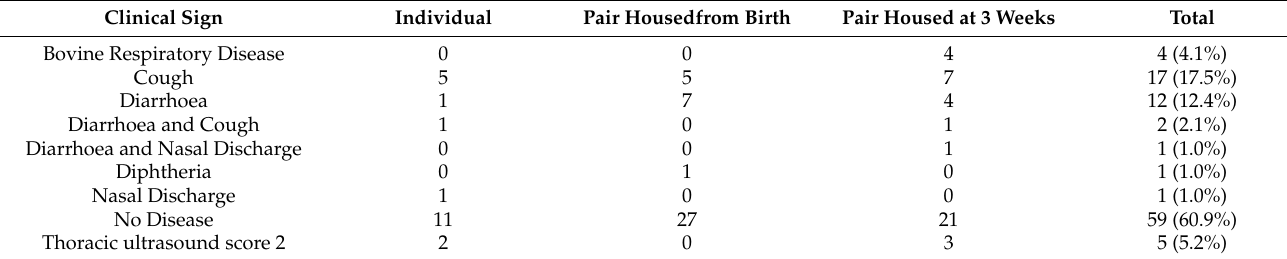
Table 1. Distribution of the disease occurrence and thoracic ultrasound score during the pre-weaning period between the different housing groups of calves. For a calf to be diagnosed as having Bovine Respiratory Disease (BRD), they must have had a raised rectal temperature ( ≥ 39.5 ◦ C) and either a cough or ocular or nasal discharge. An ultrasound score of 2 indicated lobular or patchy pneumonia with